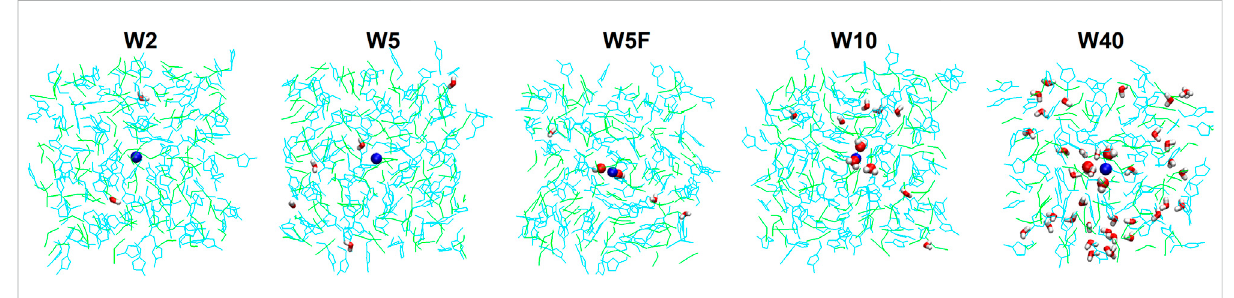
FIGURE 7 Snapshots of the simulated systems including W2, W5, W5F, W10, and W40. Water molecules in the sodium hydration shell and sodium cation are shown bythe spheremodel while EMIM + and DCA − arerepresented byline models with lightblueand green colors, respectively. The color code for atoms is sodium: blue, oxygen: red, and hydrogen: white.